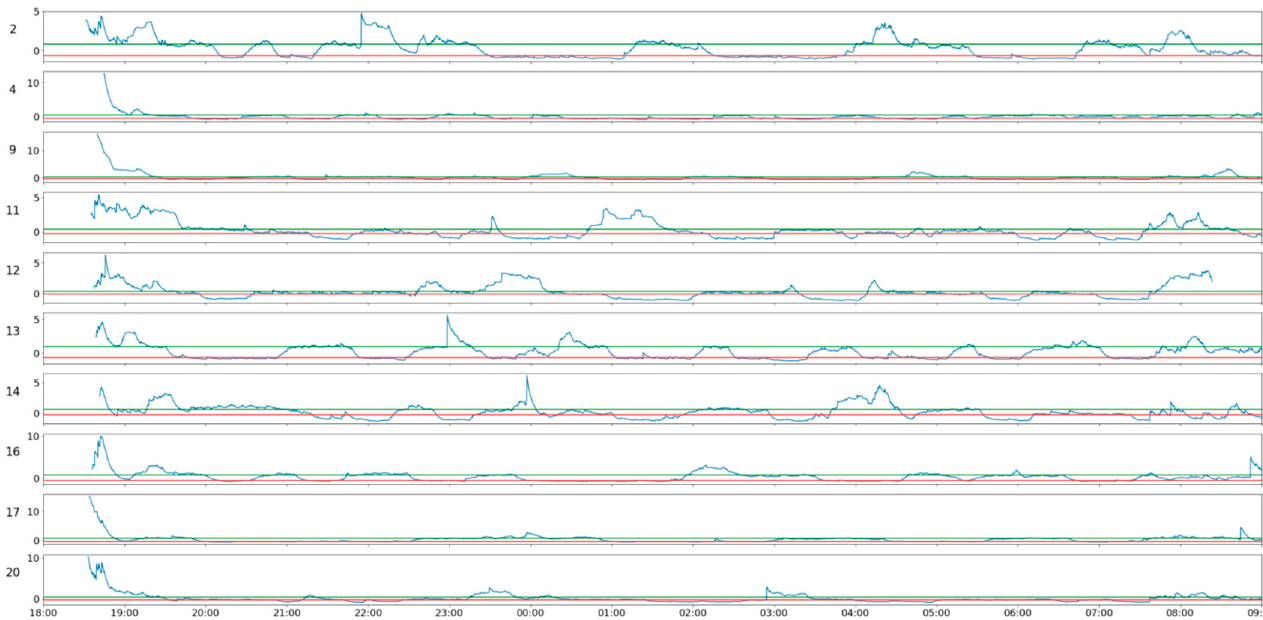
Table 1. Get-up count and get-up, lay-down, and sleep laterality analysis. Collar